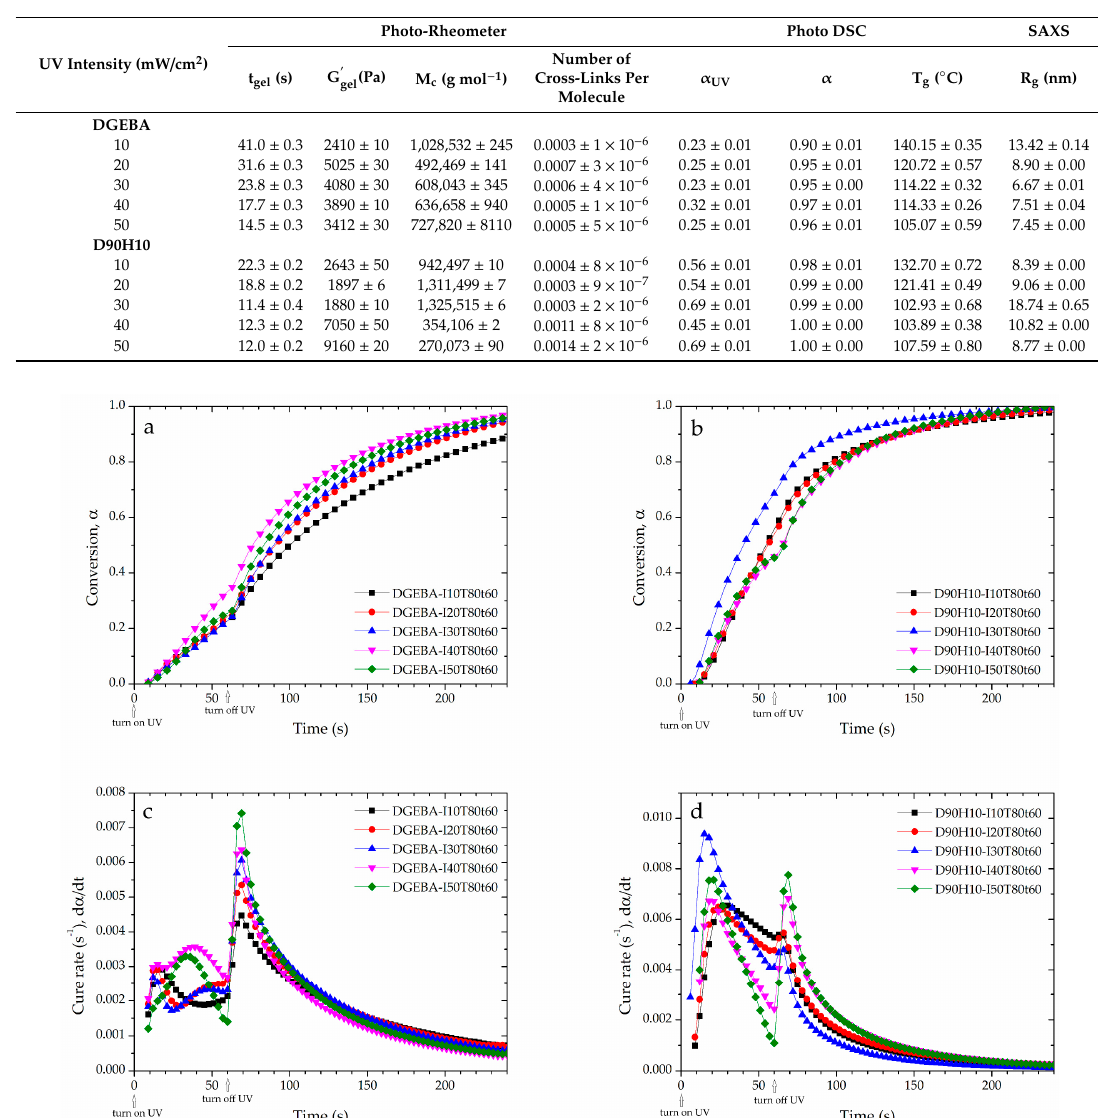
Table 2. The properties of DGEBA and D90H10 systems at various UV intensity.